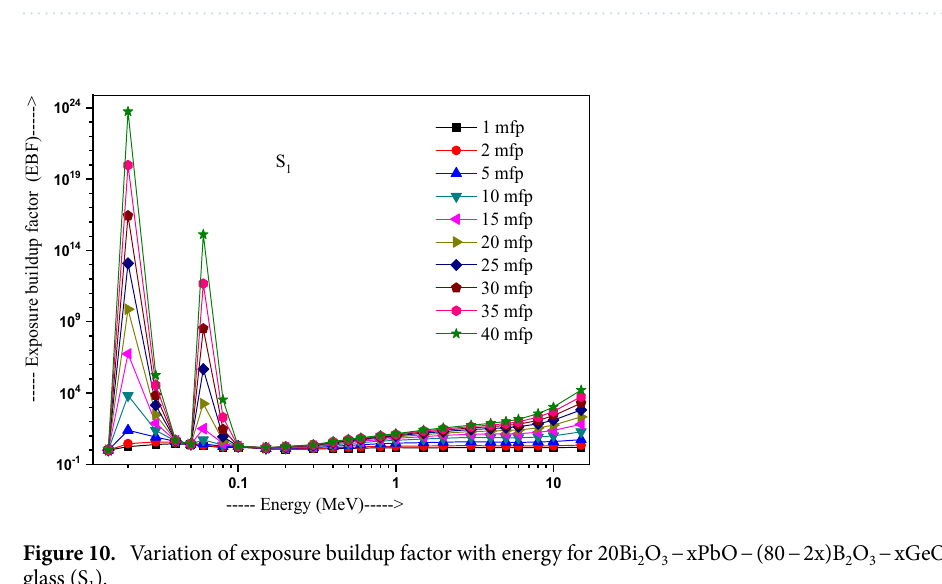
Table 3. Equivalent atomic numbers and G-P fitting parameters for EBF and EABF for sample S 4 .